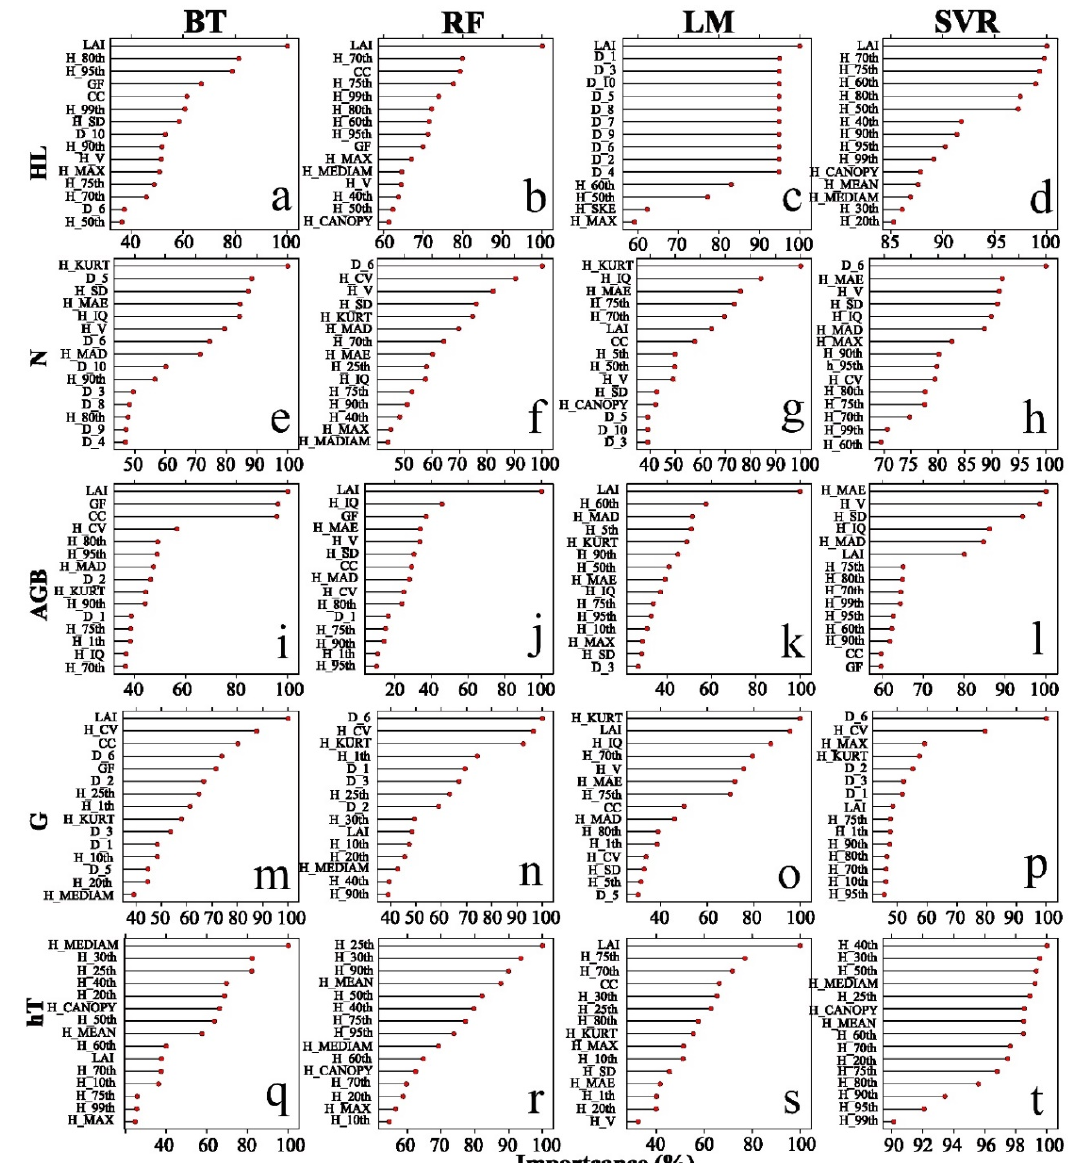
Figure 4. Relative importance of the 15 highest ranked variables for each regression method with the forest structural parameters of canopy trees. The abbreviations of the LiDAR metrics are given in Table 3.